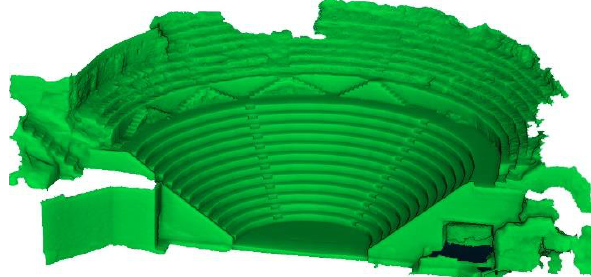
Figure 9: Polygonal model generated with Poisson